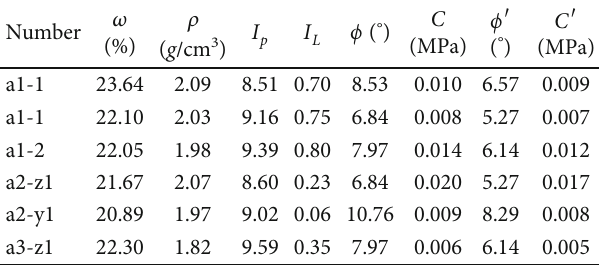
Table 3: Test results of weak interlayer soil.